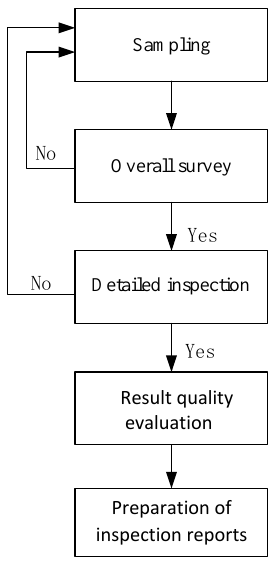
Figure 1 . Real estate registration integration inspection